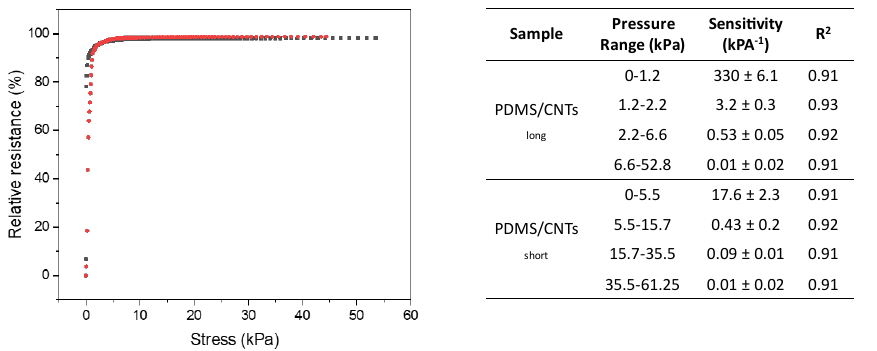
Figure 6. Relative resistance variation at different strains in PDMS/CNTs long (gray curve) and PDMS/CNTs short (red curve). The embedded table reports the recorded values observed for the different linear ranges observed in the two curves.